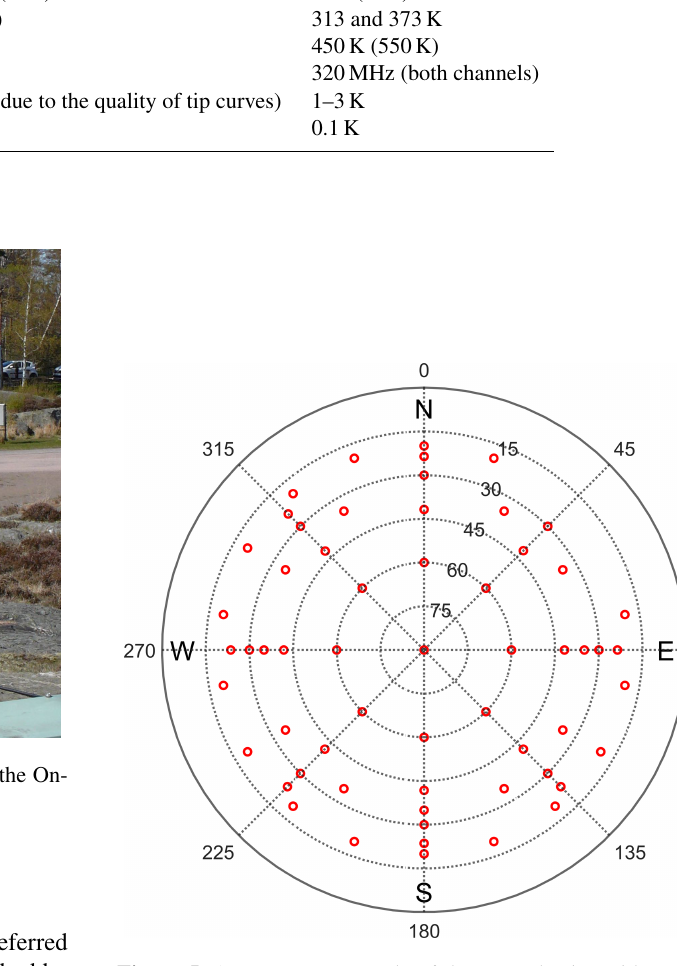
Figure 5. A measurement cycle of the WVR begins with two az- imuth scans. In order to avoid emission from the ground, the lowest elevation angle observed was 20 ◦ . Starting in the north, first turn- ing at an elevation angle of 20 ◦ clockwise to the north (excluding the azimuth angles of 40 ◦ and 60 ◦ due to a nearby radio telescope) and then turning anticlockwise at an elevation angle of 35 ◦ . There- after, four tip curves were made over the zenith direction (implying four observations in the zenith direction during each cycle): from the north to the south, from the southwest to the northeast, from the east to the west, and from the northwest to the southeast. The cycle was about 8min long and was repeated continuously, implying that almost two complete cycles with a total of ≈ 100 observations were used when estimating gradients every